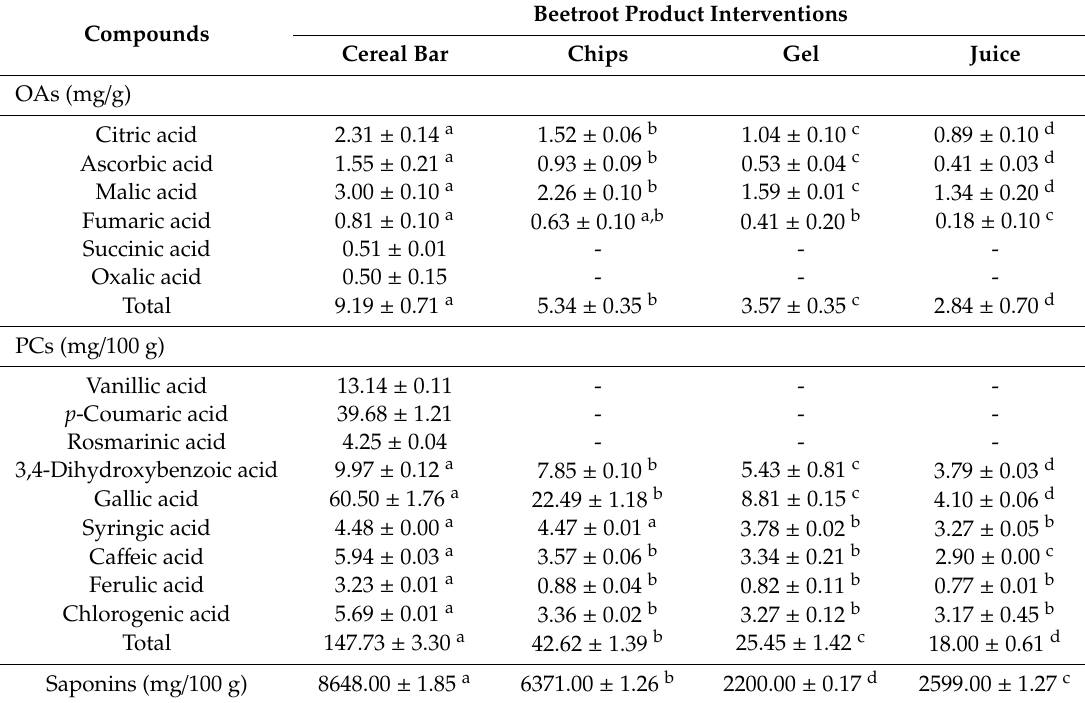
Table 2. Organic acids (OA) and phenolic compounds (PC) contents in beetroot product interventions. Beetroot Product Interventions Compounds Cereal